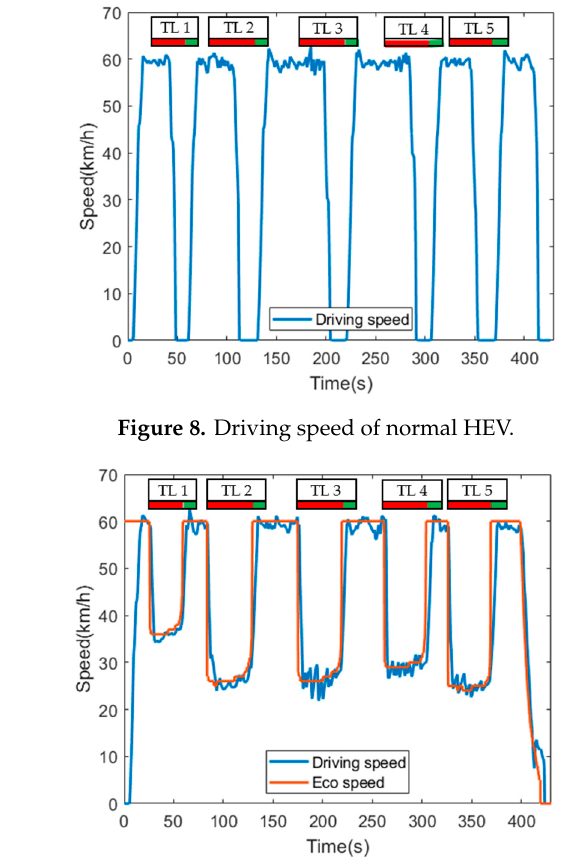
Figure 9. Driving speed of CHEV.